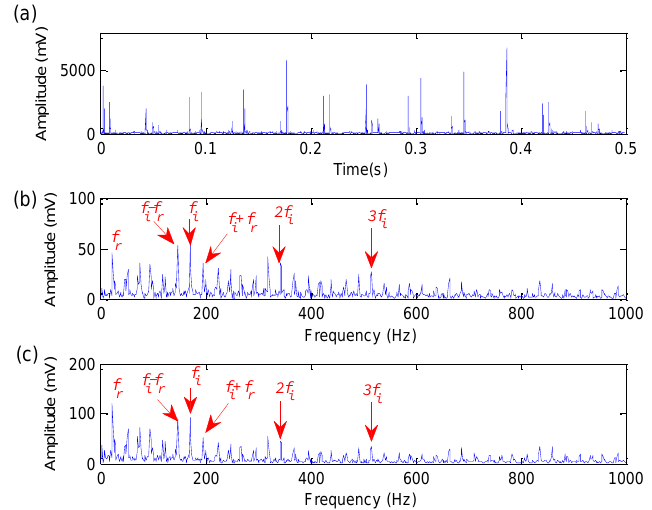
Figure 15. Analysis results obtained by the proposed method for bearing inner race fault signal: ( a ) Time domain waveform; ( b ) amplitude spectrum; ( c ) envelope spectrum.